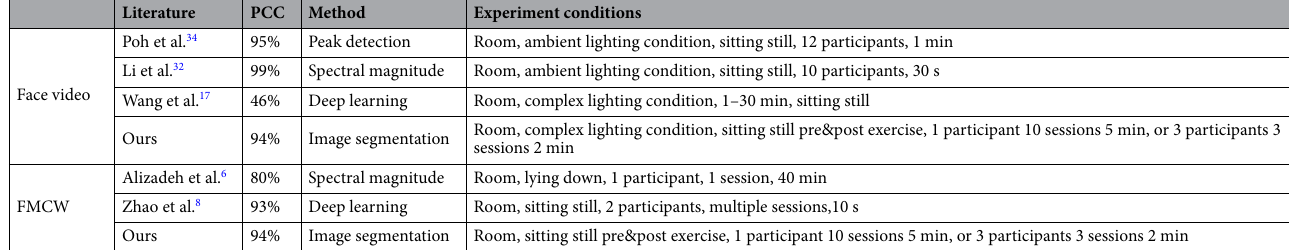
Table 2. Cross-reference performance